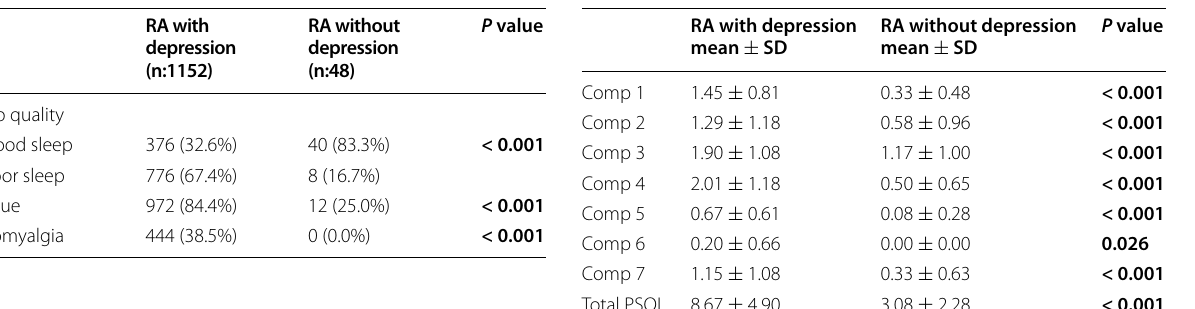
DAS28 Disease Activity Score in 28 joints, HAQ Health Assessment Questionnaire, ESR erythrocyte sedimentation rate Table 3 Symptoms related to depression in the 2 patient groups Table 4 Global PSQI and its component scores in the 2